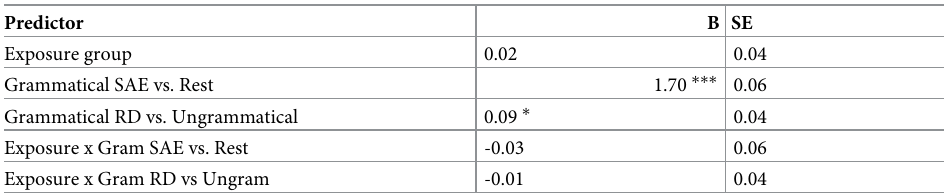
Table 7. Experiment 3 acceptability fixed effects